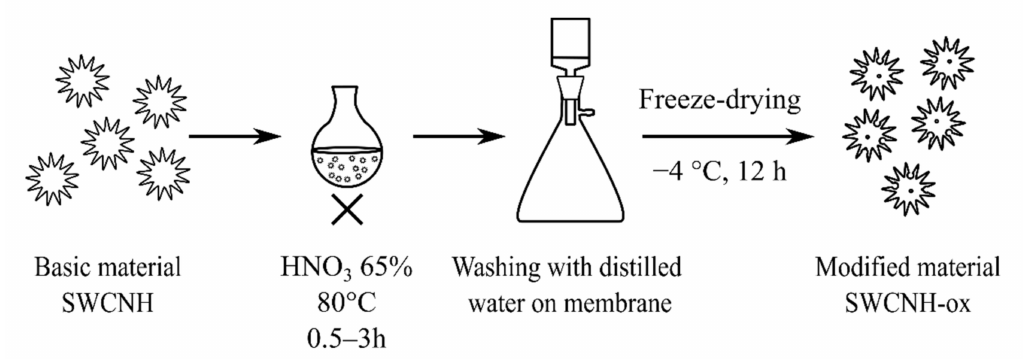
Figure 1. Schematic representation of the studied sample